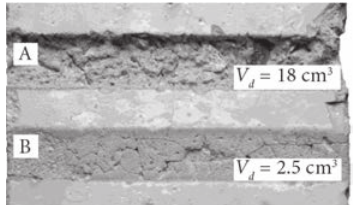
Fig. 4. Example of slots created by flat pulsating jet (A) and flat continuous jet (B) in C45/55 concrete ( V d – disintegrated volume, water pressure: 30 MPa, equivalent nozzle diameter: 2.05 mm, standoff distance: 40 mm, traversing velocity: 0.2 m.min –1 )